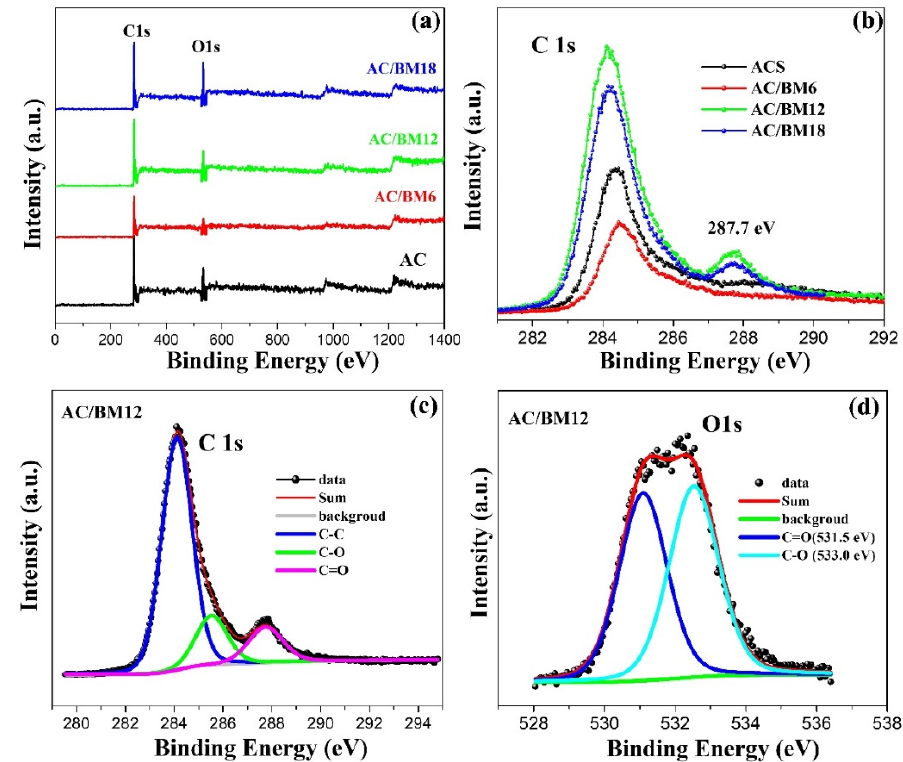
Figure 5. ( a ) Full spectrum of all samples, ( b ) comparison of the C 1s spectra of all samples, ( c ) fitting of C 1s spectrum and ( d ) fitting of O 1s spectrum for AC/BM12. Table 2. Elemental composition of AC, AC/BM6, AC/BM12 and AC/BM18 samples.